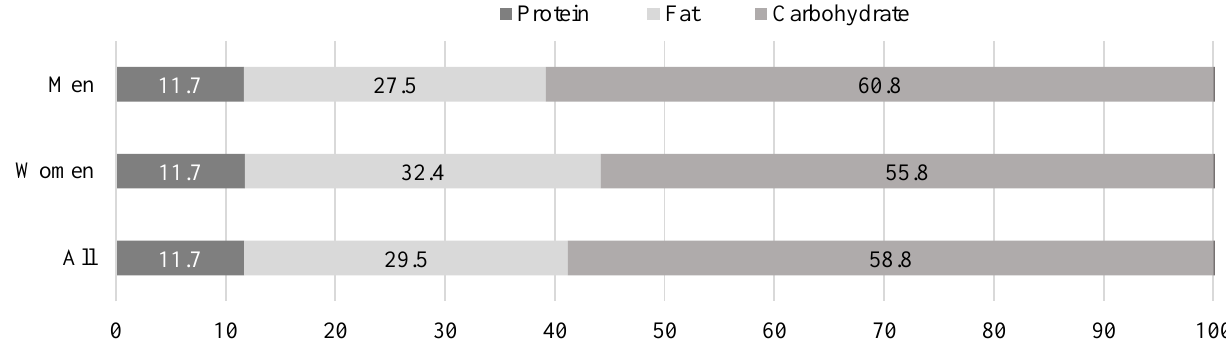
Figure 2. Contribution of protein, fat, and carbohydrate to the total energy intake (%).